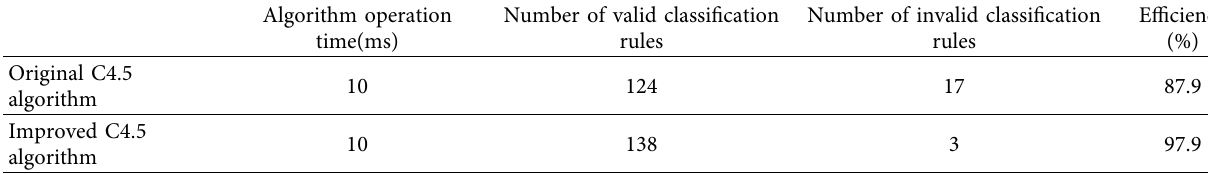
Table 2: Performance comparison of C4.5 algorithm before and after improvement.